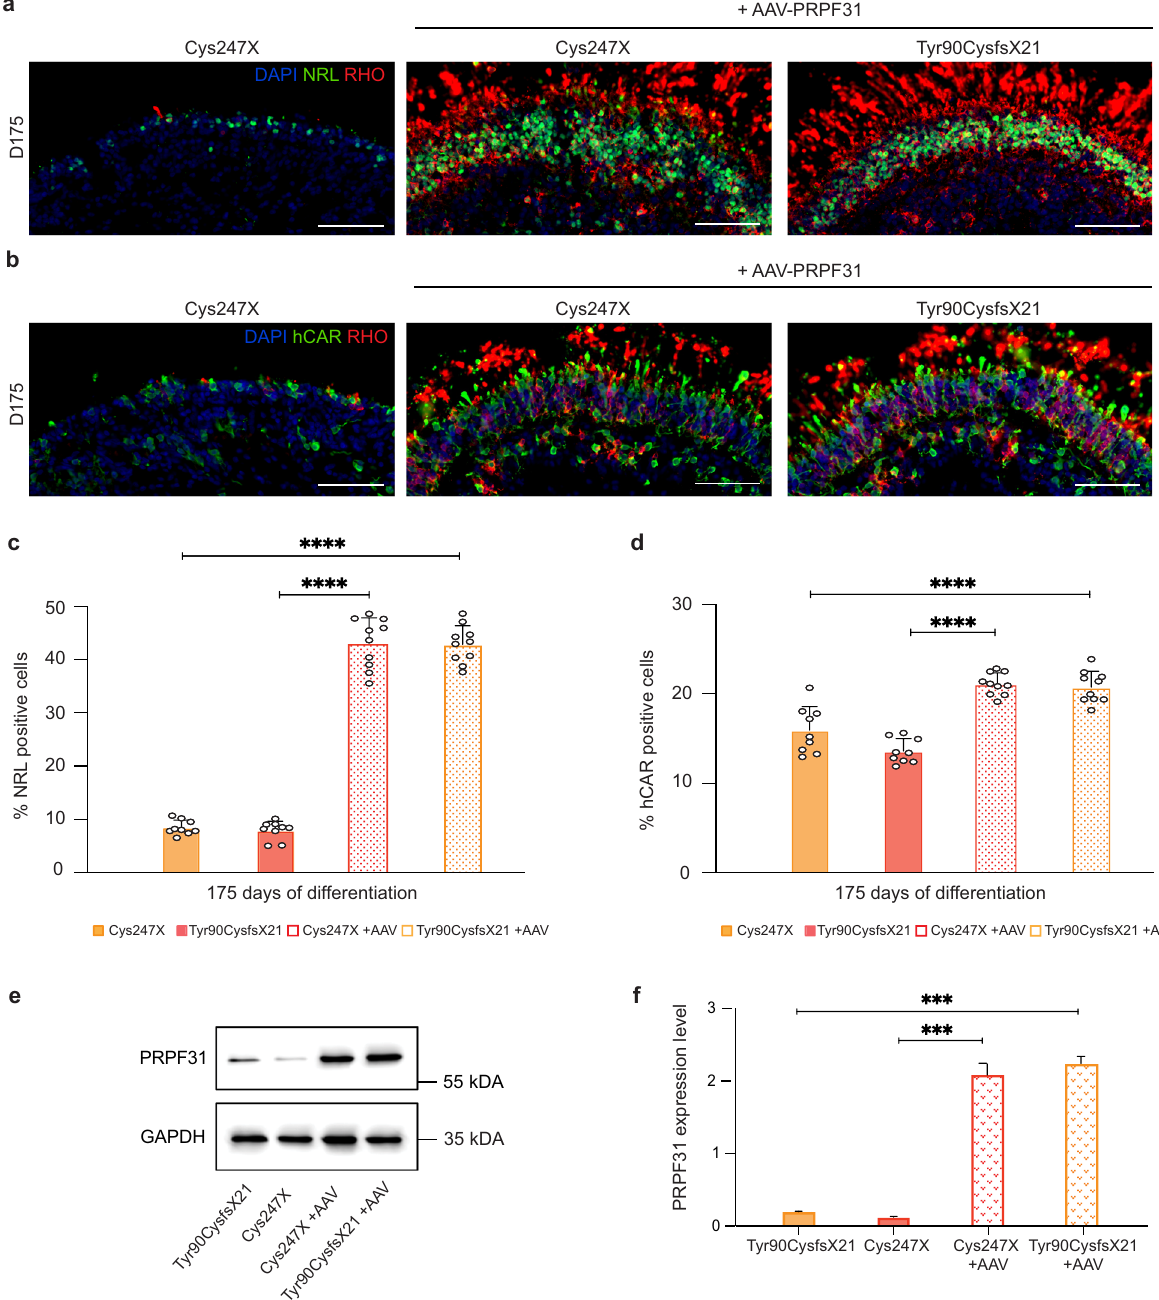
Fig. 7 Photoreceptor degeneration phenotype can be rescued by AAV-driven PRPF31 overexpression. a , b Immuno fl uorescence staining of cryosections of PRPF31 -mutated (Cys247X) retinal organoids and PRPF31 -mutated retinal organoids transduced with PRPF31-AAV (Cys247X + AAV- PRPF31 ) at D175 using markers for rod (NRL and RHO) and cone (hCAR) photoreceptors. Nuclei were counterstained with DAPI. Scale bar = 100 µm. c , d Quanti fi cation of the percentage of NRL or hCAR-positive cells in D175 retinal organoids. Each data point represents manual counts of NRL or hCAR-positive cells relative to DAPI-positive cells performed on one-quarter of a representative cross- section of one organoid. Values are mean ± SD, for each time point n ≥ 9 independent retinal organoids from N ≥ 3 independent differentiations. Statistical signi fi cance assessed using the Kruskal – Wallis test (**** P < 0.0001). e Representative image and f quantitative analysis of western blots showing PRPF31 protein levels relative to GAPDH expression in retinal organoids at D130. Values are mean ± SD, n = 6 samples from N = 3 independent experiments. Statistical signi fi cance assessed using the Kruskal – Wallis test (*** P < RP 23,24,47 . It is not known why Prpf31 mutant mice have only an cells than in the neural retina could partly explain this RPE degenerative phenotype and do not present the key phenotype of PRPF31 -related RP patients, i.e . the photoreceptor cell death. The higher level of Prpf31 expression in murine RPE